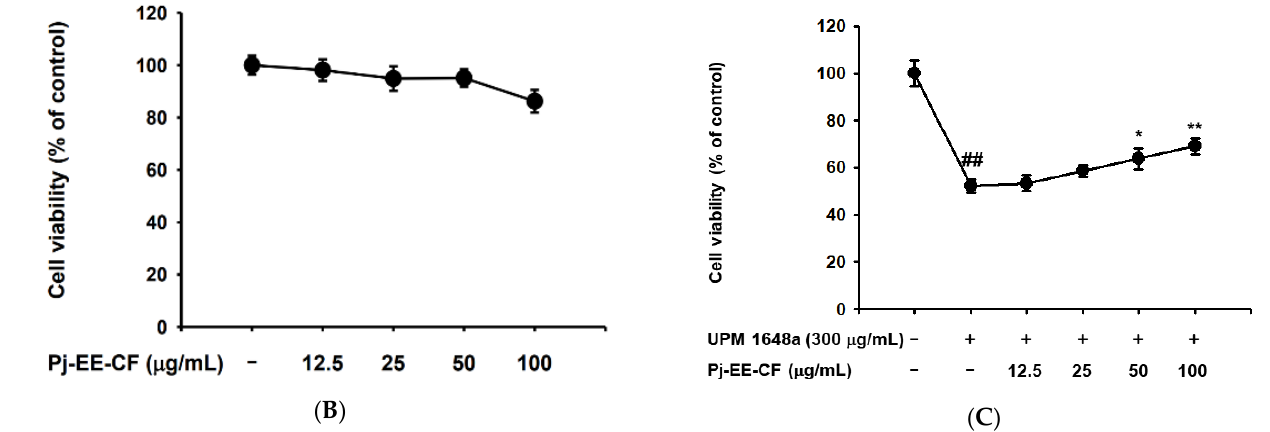
Figure 1. Cytotoxicity and cytoprotective effects of Pj-EE-CF in BEAS-2B human bronchial epithelial cells. ( A ) Fractionation diagram of the various solvents of P. japonica ethanolic extract (Pj-EE). ( B , C ) BEAS-2B cells were treated with UPM1648a (300 µ g/mL) and Pj-EE-CF (0–100 µ g/mL) or Pj-EE-CF (0–100 µ g/mL) alone for 24 h. Cell viability was analyzed analytically by MTT. Data in ( B , C ) are presented as mean ± SD of six replicates ( n = 6). ## p < 0.01 compared to normal (non-treatment), * p < 0.05 and ** p < 0.01 compared to control (UPM 1648a alone).